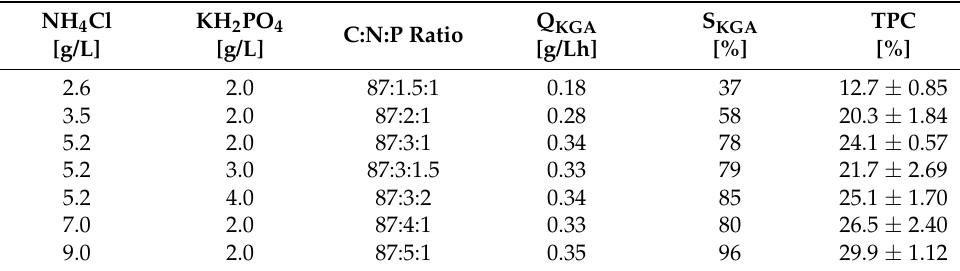
Table 2. Comparison of parameters obtained after α -ketoglutaric acid production by by Y. lipolytica